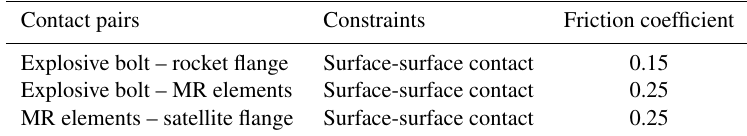
Table 2. Contacts and constraints settings in the system.